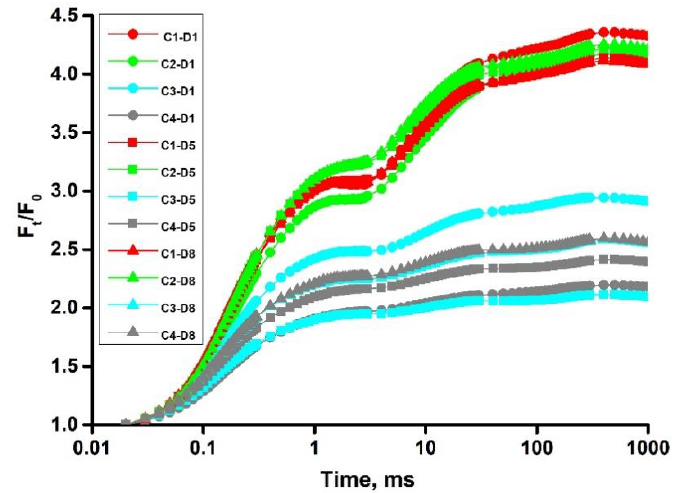
Figure 1. OJIP fluorescence transients expressed as F t /F 0 = f(t), induced by strong red actinic light (3.000 µ mol photons m − 2 s − 1 ; peak at 650 nm) and measured with a plant efficiency analyzer (Handy PEA; Hansatech Instruments Ltd., Norfolk, UK) in S. pectinata leaves and dark-adapted for 30 min. Induction curves plotted on logarithmic scale from 20 µ s to 1 s (JIP-time). Experimental conditions C1: salinity 9 and irradiance 100 µ mol photons m − 2 s − 1 , C2: salinity 19 and irradiance 100 µ mol photons m − 2 s − 1 , C3: salinity 9 and irradiance 400 µ mol photons m − 2 s − 1 , C4: salinity 19 and irradiance 400